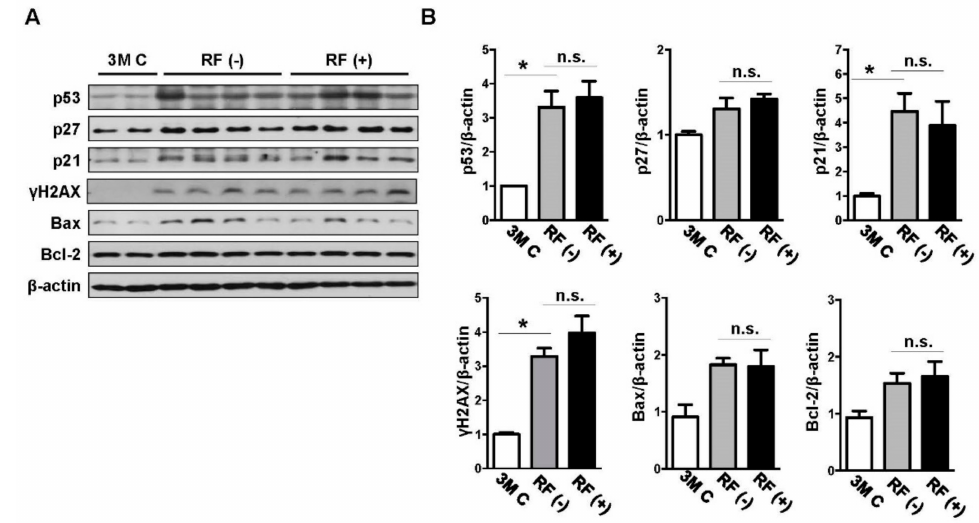
Figure 3. Effects of RF-EMF exposure on the protein expression levels of p53, p27, p21, γ H2AX, Bax, and Bcl-2 as determined by western blotting analysis. ( A ) Western blot images of DNA damage-related proteins in the mouse brain following RF-EMF exposure. ( B ) The graphs show the quantification of p53, p27, p21, γ H2AX, Bax, and Bcl-2 protein levels in young-aged (3M C), sham-exposed (RF ( − )), and RF-exposed (RF (+)) mouse brains based on band intensity. The values are presented as means ± SEM. * p < 0.05 versus young-aged (3M C) group. n.s.: no significance.